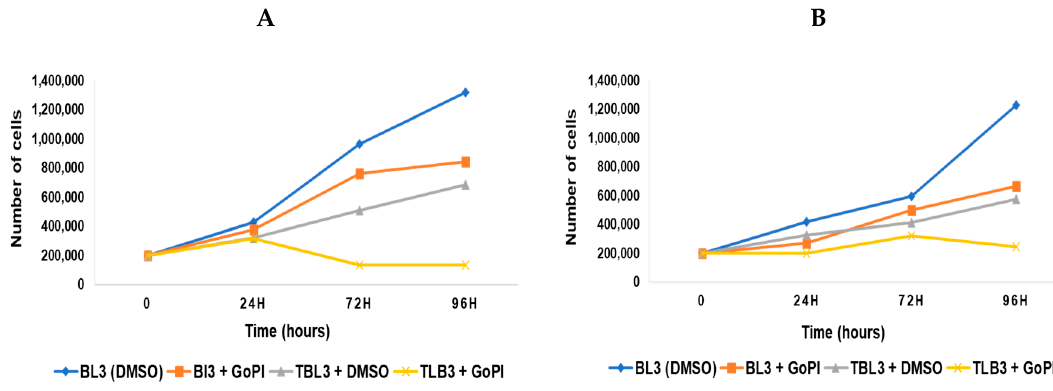
Figure 3. Effects of GoPI-sugar complex on the proliferation of non-infected bovine lymphosarcoma cells (BL3) and Theileria annulata -infected cells (TBL3) treated with GoPI-sugar complex at 0.25 µM ( A ) and 0.5 µM ( B ) for 96 h.